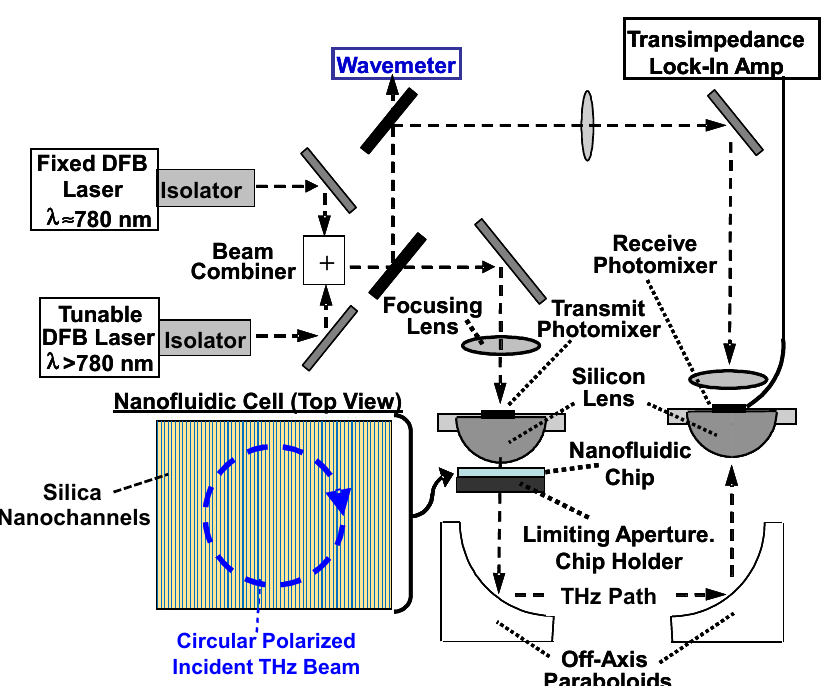
Figure 1. THz photomixing spectrometer with nanofluidic chip in the beam path. The chip dimen- sions are 5 × 5 mm and the THz beam has a 3 mm diameter, so underfills the chip. The nanochannels are not shown to scale, as there are approximately 5000 parallel nanochannels per chip.